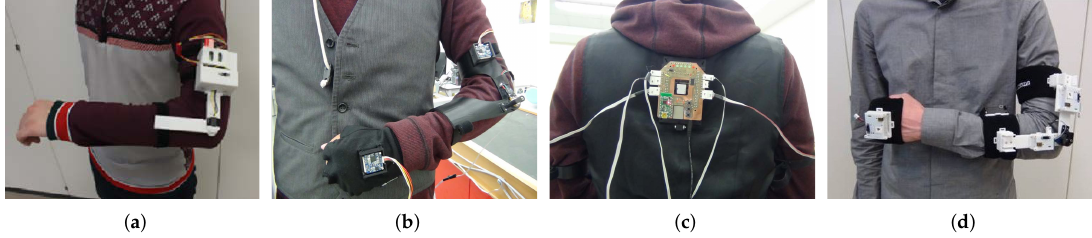
Figure 2. Evolution of the arm motion-tracking system designs: ( a ) the 4-DOF system (Phase 1) [22]; ( b , c ) the 7-DOF double-arm system used in [30] (Phase 2); ( d ) the final 7-DOF system (Phase 3) used in [31].